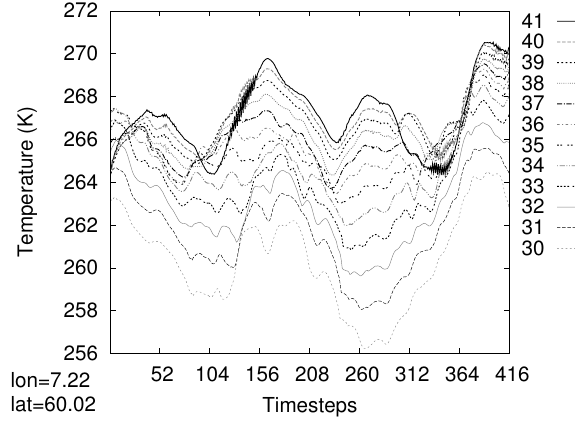
Fig. 4. The amplitude of 2∆ t temperature oscillations on the lowest model level (in Kelvin) after 96h forecast for the referent model run computed according to Eq. ( 9).